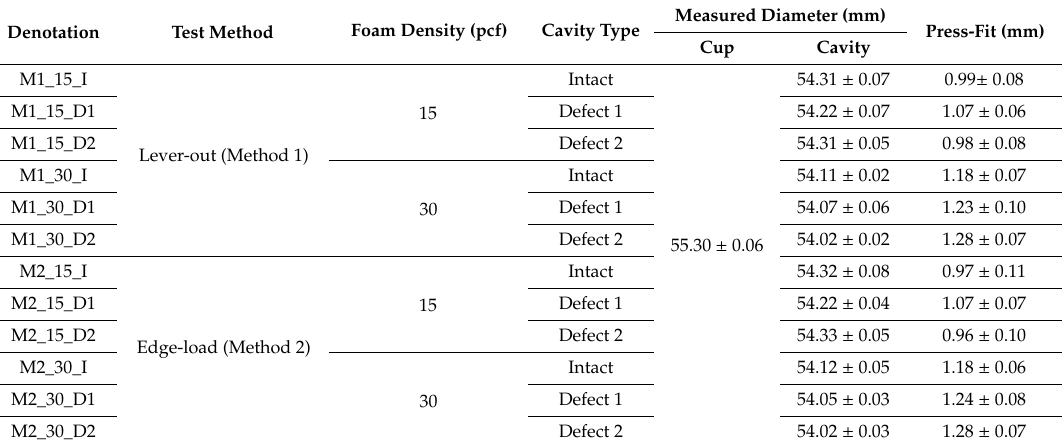
Table 1. Denotation and classification of the test sample groups based on the combination of test methods, foam densities, and cavity types, including the measured cavity diameter.